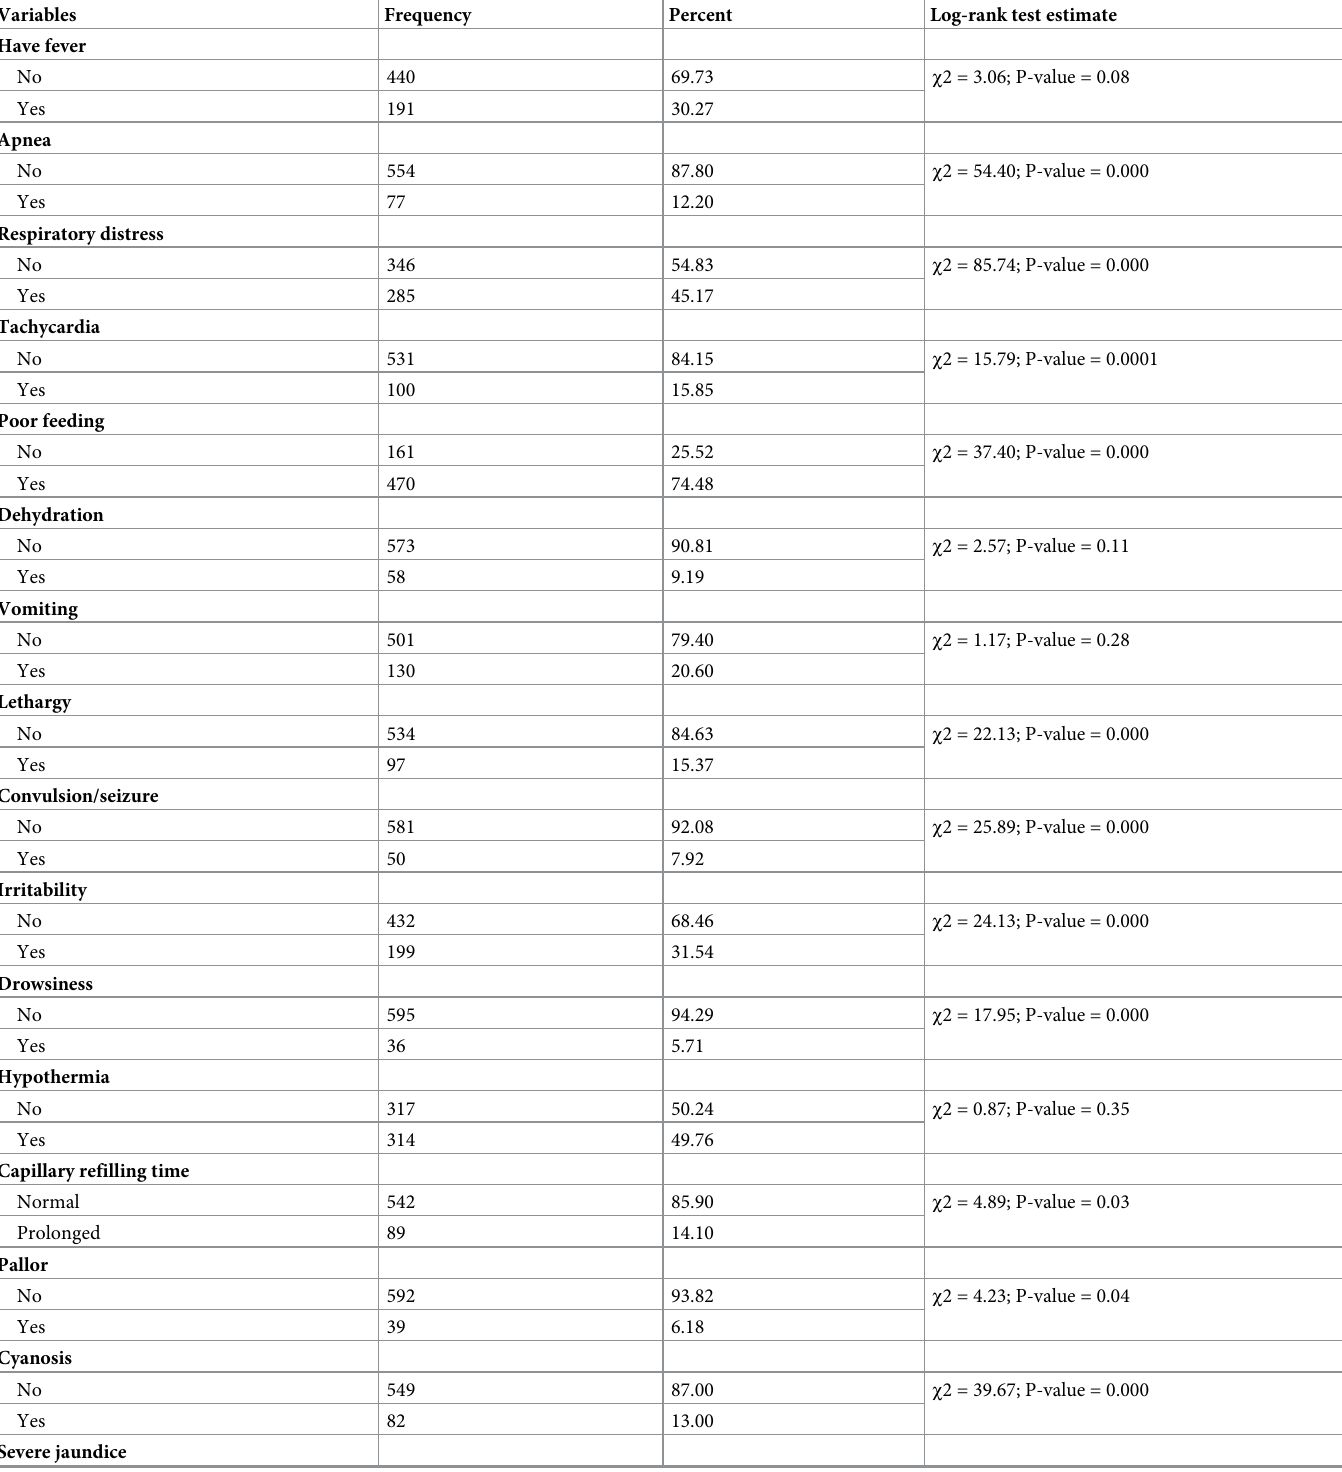
Table 3. The clinical features/presentation of neonates with sepsis/related characteristics in Public Hospitals of Central Gondar Zone, 2021 (n =